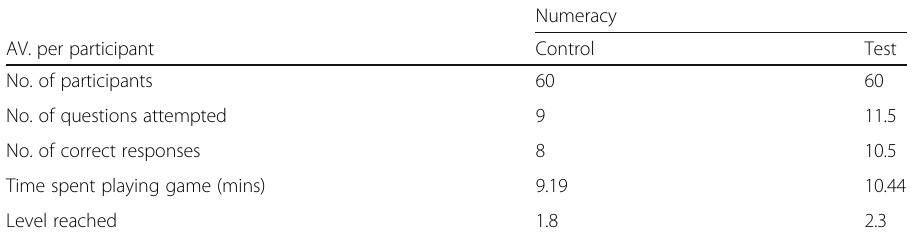
Table 2 Interaction logs for Test and Control